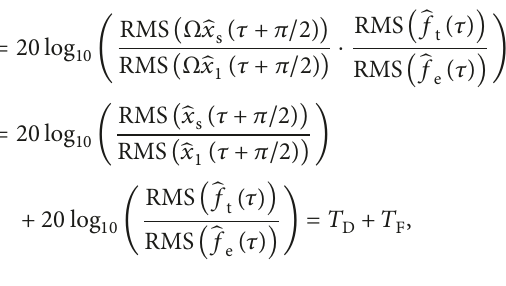
𝑚 1 , (b) FRC of 2 , and (c) FRC of